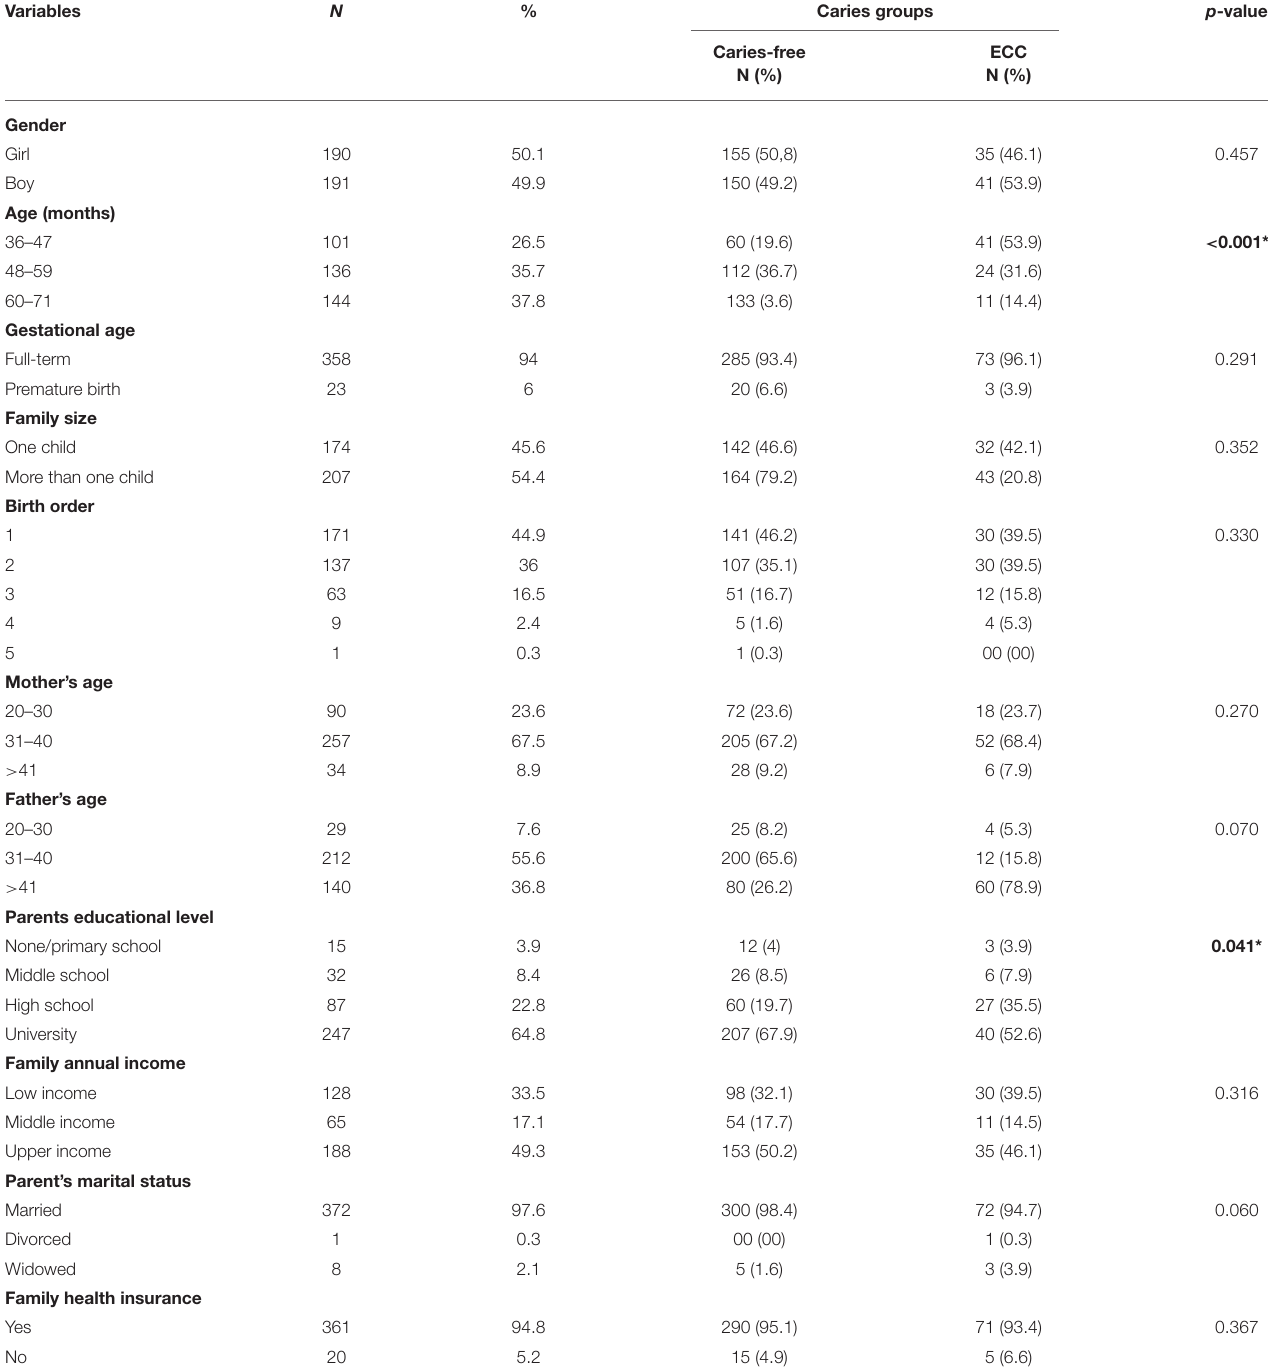
TABLE 1 | Prevalence of ECC and associated socioeconomic factors ( N = 381). Variables Caries groups p